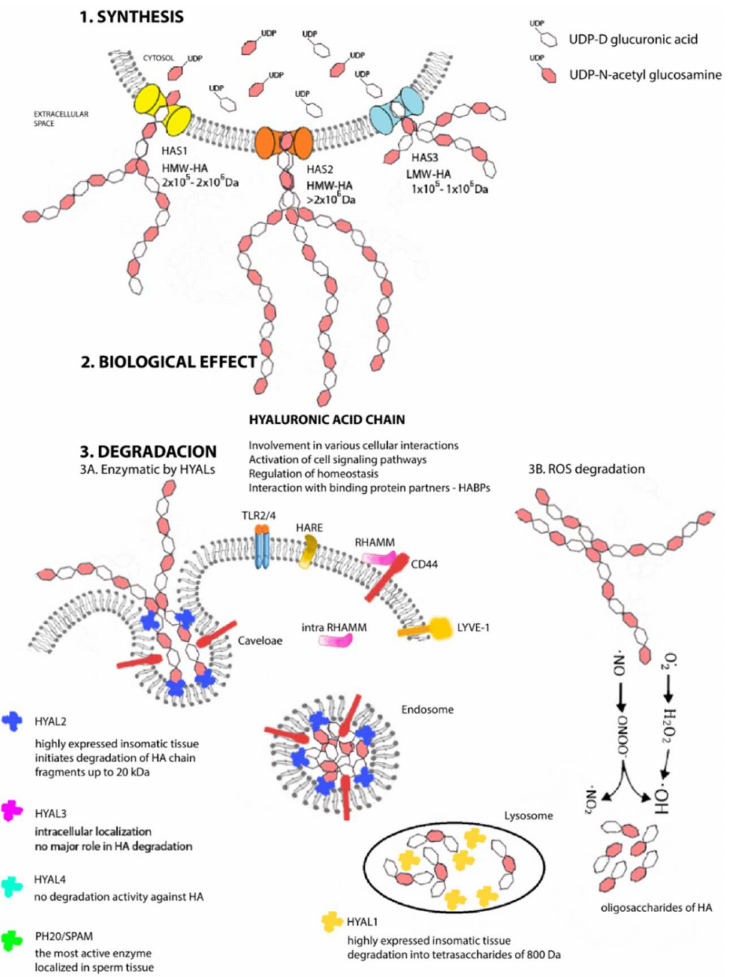
Figure 2. Metabolism of hyaluronan. Structural scheme of synthesis ( 1 ), biological effect ( 2 ), and degradation ( 3 ) of HA under physiological conditions in mammal cells. Cytosolic molecules of UDP-D glucuronic acid and UDP-N-acetyl glucosamine serve as precursors for HA chains. The enzymatic reaction is catalyzed by three HAS proteins, which synthetize unique HA chains varied in lengths that differ in their biological function in the organism ( 1 ). Hyaluronic acid chains are involved in many cellular interactions, in signaling pathways, binding activities with other proteins, or are involved in process of homeostasis ( 2 ). In vivo degradation proceeds in parallel in two ways (enzymatically ( 3A ) and chemically ( 3B )). Specific hyaluronidases (HYAL1—HYAL3 and PH20/SPAM) are localized in different tissue of organism and initiates the degradation of HA chain (HYAL1 in lysosomes, HYAL2 in inner part of endosome membranes, and HYAL3 in cellular membrane). Enzyme PH20 SPAM is localized in testis. Free radicals provide the random chemical degradation ( 3B ) of HA chains and after a longer exposure, fragmentations occur with a consequent increase in the number of small HA